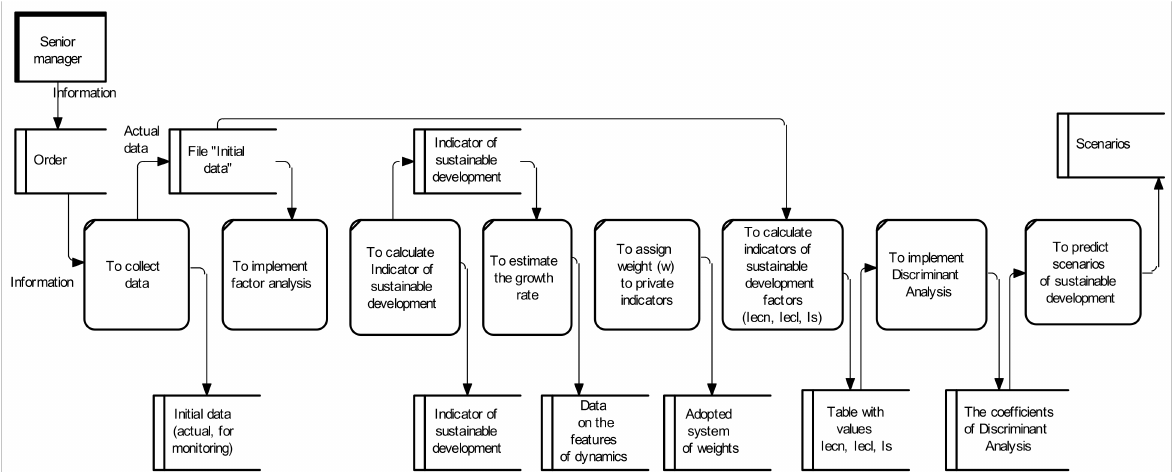
Figure 3. Model of the scenario prediction process of sustainable industrial development in DFD notation.